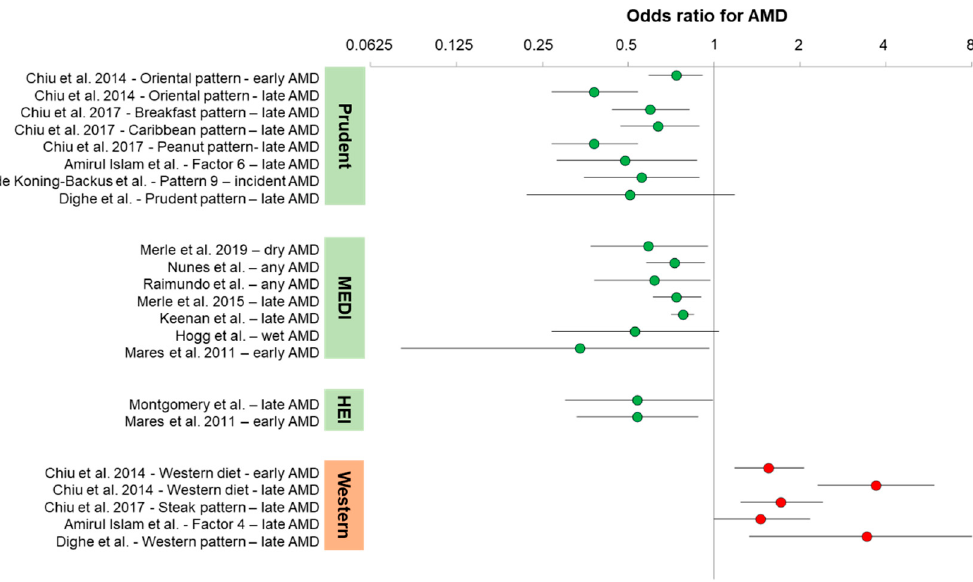
Figure 1. Odds ratios or relative risk ratios for age-related macular degeneration (AMD) from studies described in text (Sections 2.1–2.4).